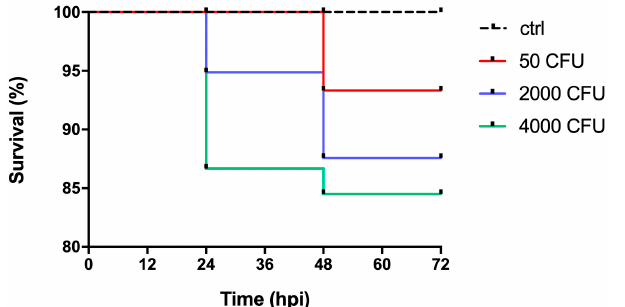
Figure 1. Zebrafish survival to P. aeruginosa infections. Kaplan–Meier survival curves of zebrafish embryos microinjected in the pericardial cavity as described in Section 4.2, with increasing doses of PA14 wild-type or PBS alone (ctrl). The survival was calculated as a percentage of the total injected embryos ( n = 15) for each treatment group and was monitored at post infections time intervals (hpi). Data were obtained from one experiment representative of three independent experiments.